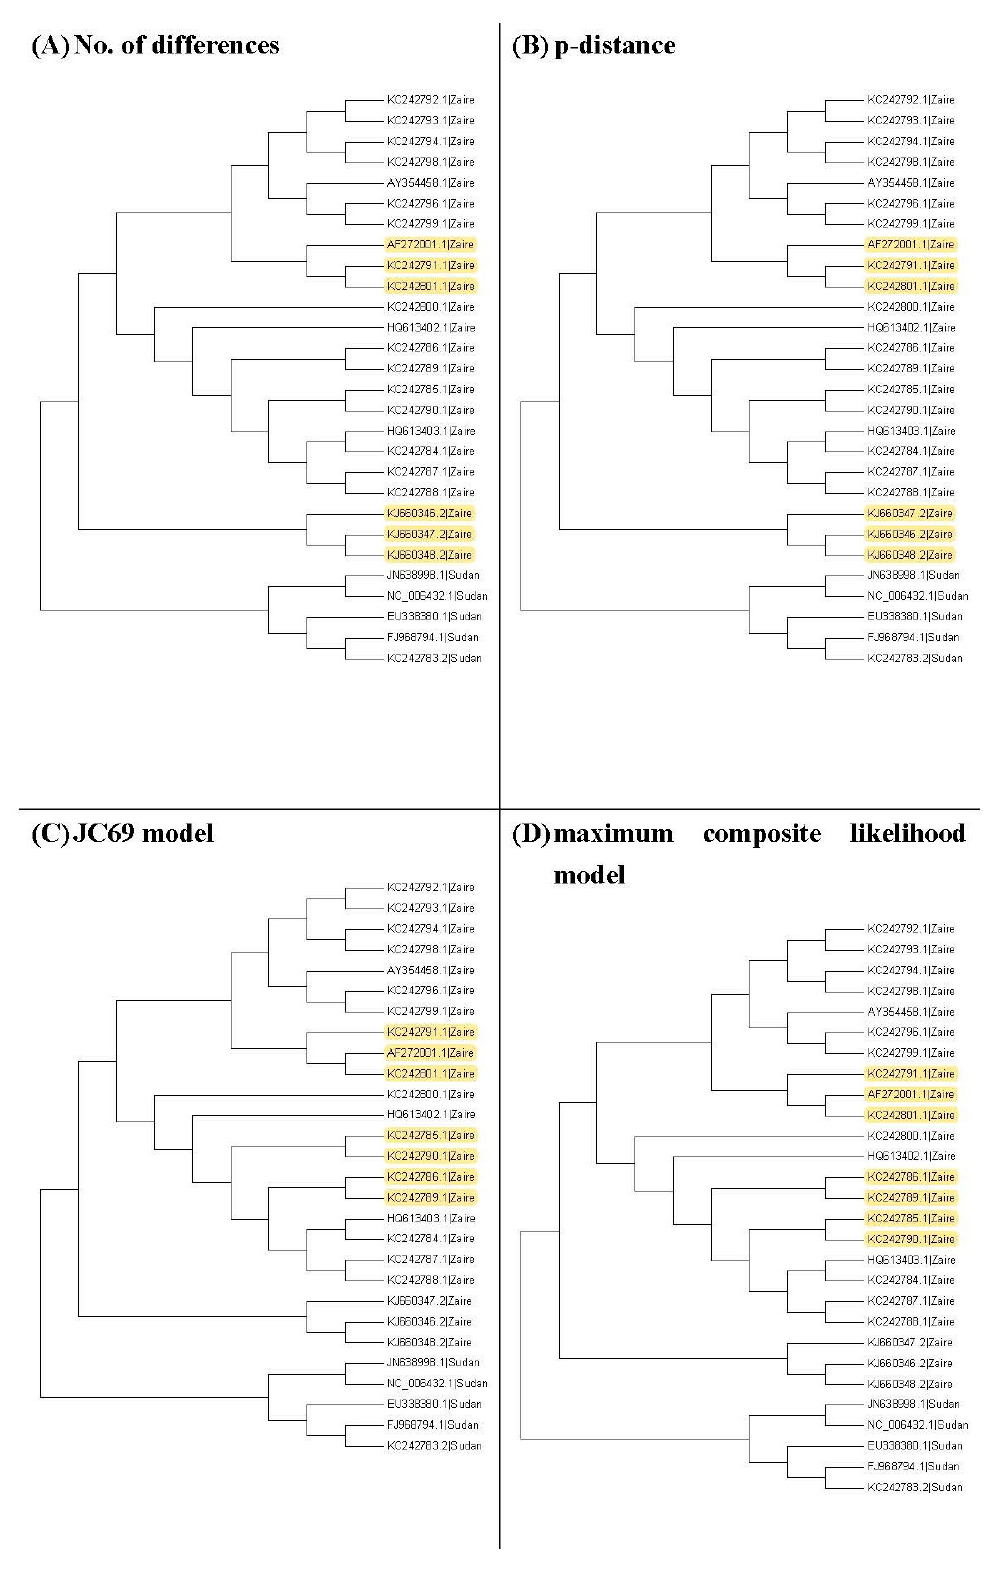
Figure 4. The neighbor-joining trees for the 28 Ebolavirus sequences. Yellow color: difference.